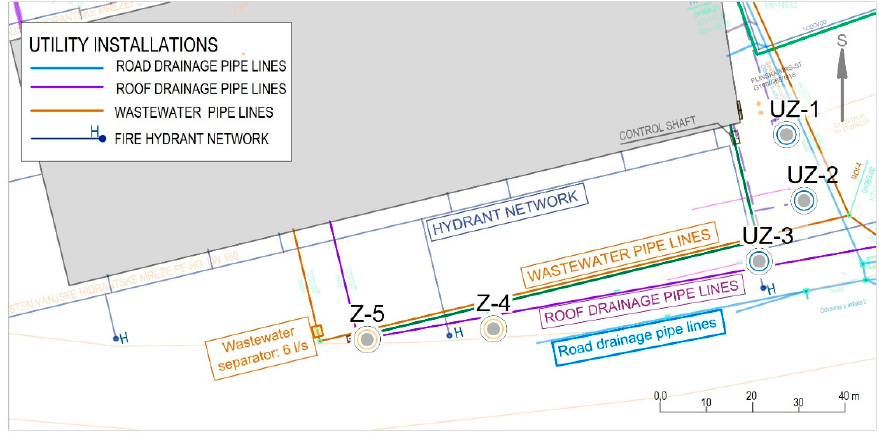
Figure 26. Overview of water supply installations and sanitary and precipitation drainage.